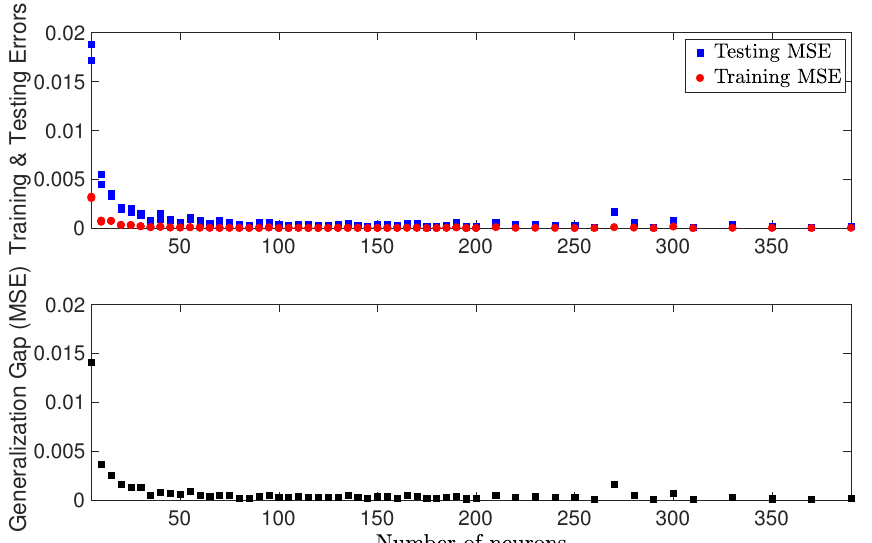
Figure 3. RNN generalization performance vs. RNN width (One hidden layer with increasing number of neurons).